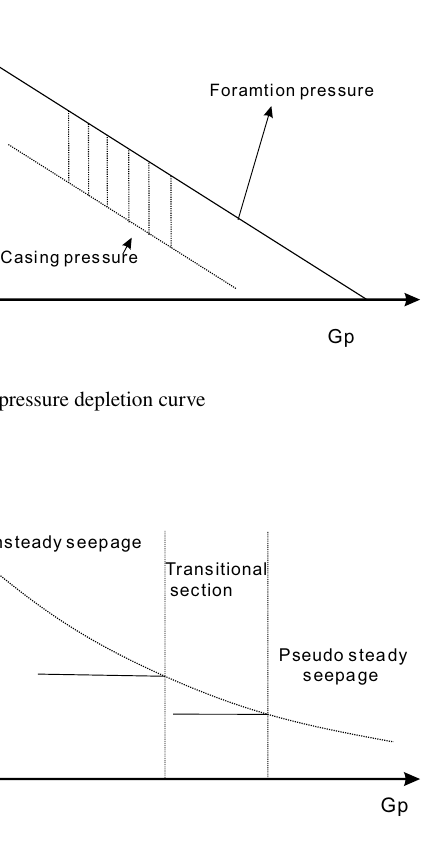
Fig. 9 Elastic two-phase theoretical curve